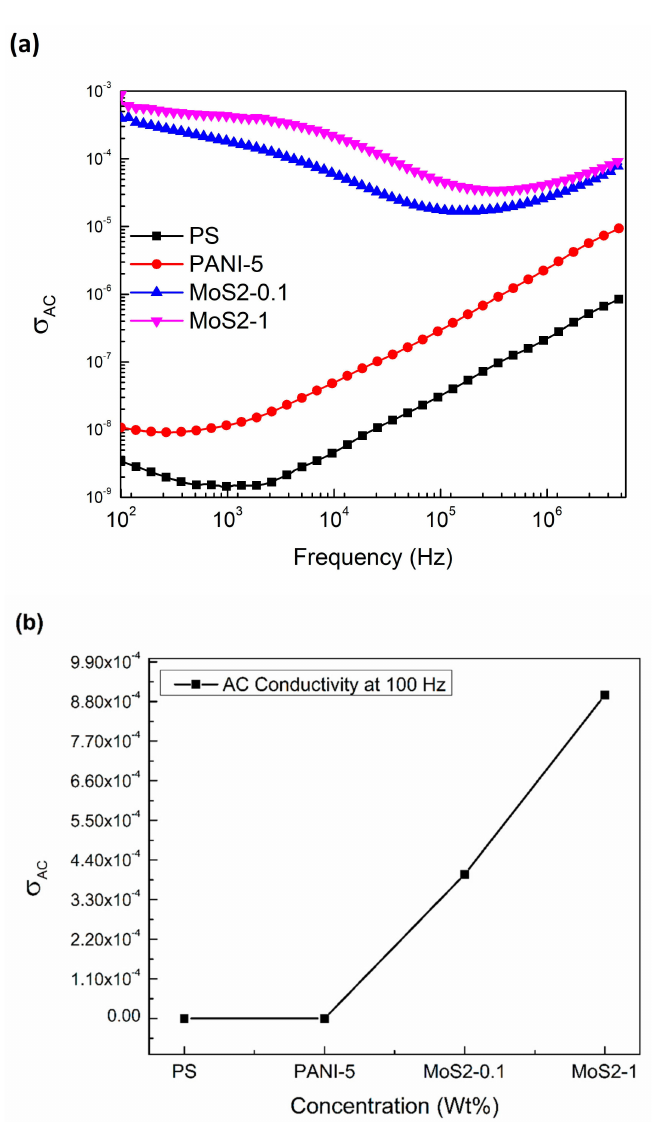
Figure 6. Alternating Current (AC) conductivity of ( a ) PS, PANI, PS / PANI-5 wt % polymer blend, and PS / PANI / MoS 2 hybrid polymer composites as a function of frequency. Values of AC conductivity for ( b ) PS, PANI, PS / PANI-5 wt % polymer blend, and PS / PANI / MoS 2 hybrid polymer composites at 100